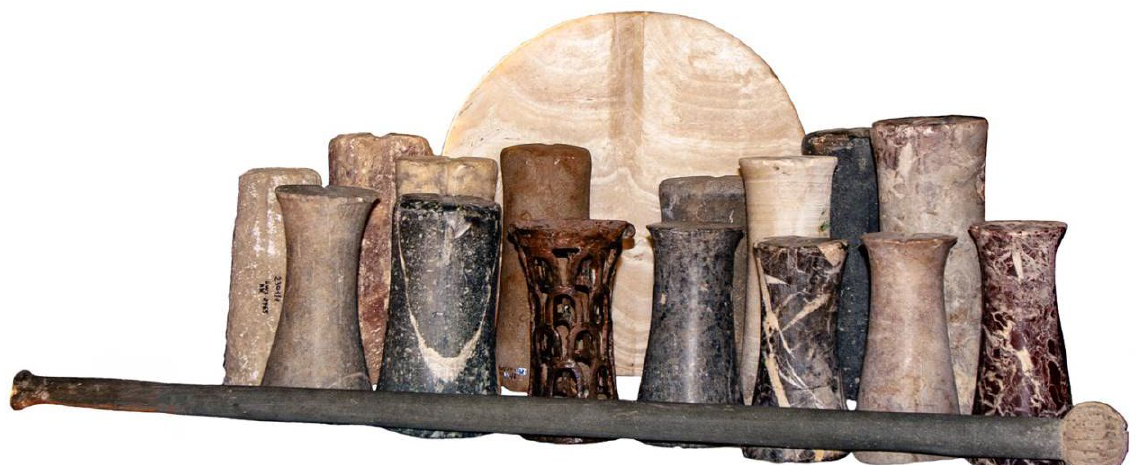
Figure 1. Stone miniature columns from Gonur Depe, Adjikui Depe, and Ulug Depe, “staff”, disc, and metal censer in the form of a miniature column from Gonur Depe (from the depositories of the National Museum of Turkmenistan,